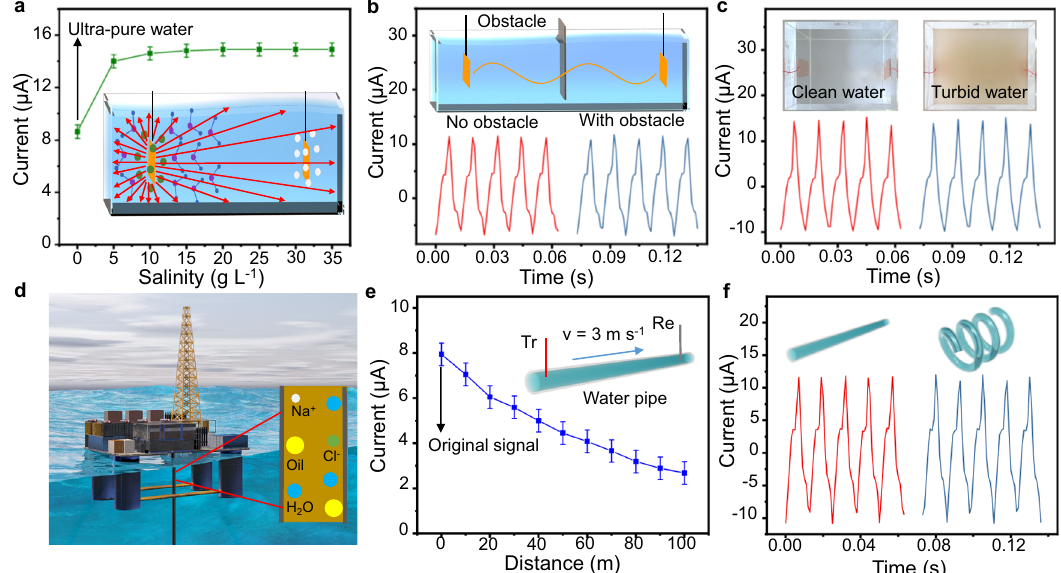
Fig. 4 Effects of disturbances on the underwater electric fi eld transmission. a Effect of water salinity on the peak value of the current. Error bars indicate standard deviations, with all values ≤ 0.53. b In fl uence of an obstacle on the current signals. c Comparison between the received current signals in clean water and those in turbid water. d Schematic diagram of the drilling platform with oil pipeline. e Variation of the peak value of short-circuit current output transmitted in a water pipe of 100 meters. Tr and Re represent transmitting and receiving electrodes respectively. v is the liquid fl owing speed. Error bars indicate standard deviations, with all values ≤ 0.46. f Comparison between the short-circuit current signals transmitted in a straight and those in a curved water